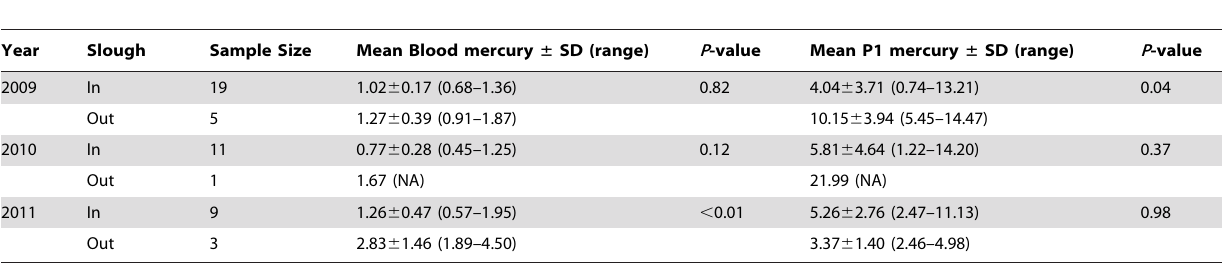
Table 2. Mean blood and first primary feather (P1) mercury concentrations (ppm ww and fw, respectively) for Nelson’s Sparrows captured near Grand Forks, ND over three breeding seasons.